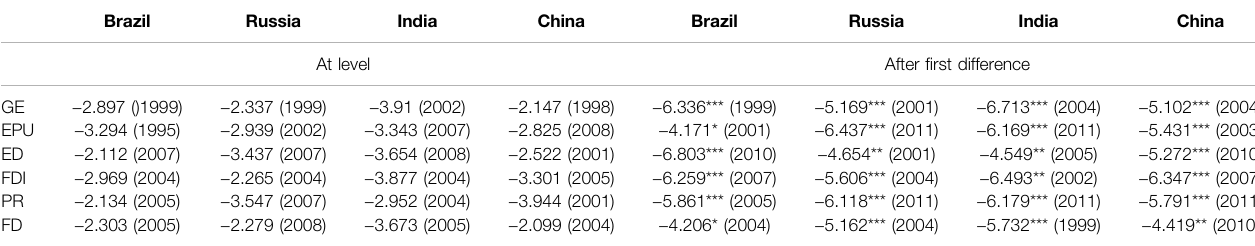
TABLE 3 | Result of Zivot Andrew Structural Break Unit Root Test.